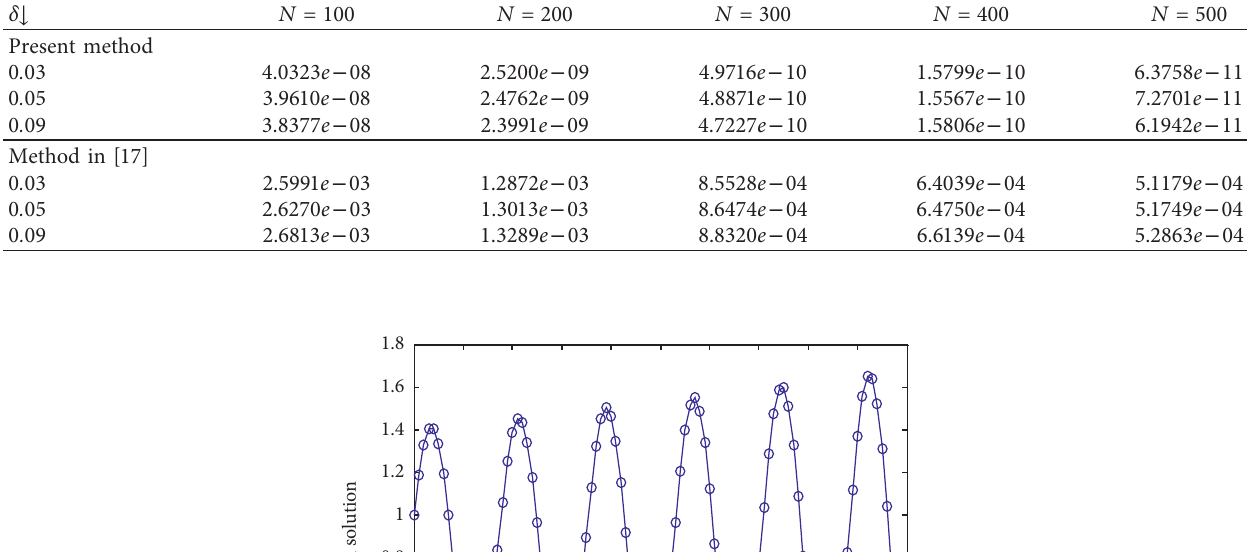
Table 5: The maximum absolute errors of Example 3 for different values of δ with ε � 0 . 1 .